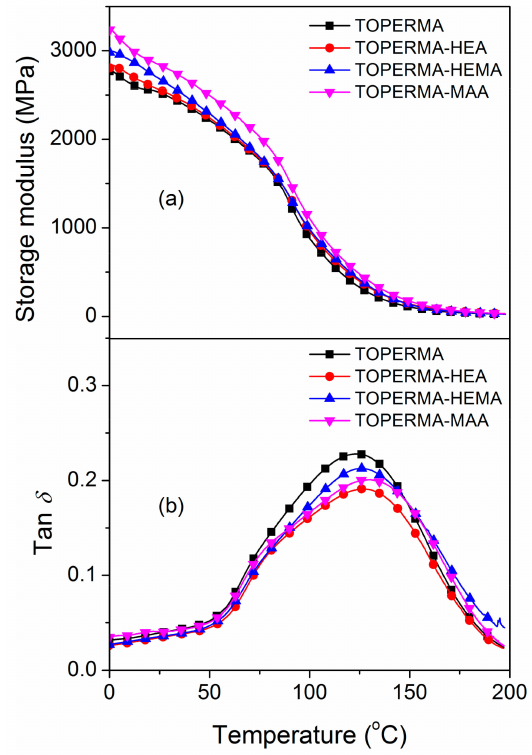
Figure 3. ( a ) Storage modulus and ( b ) loss factor of the cured, TO-based